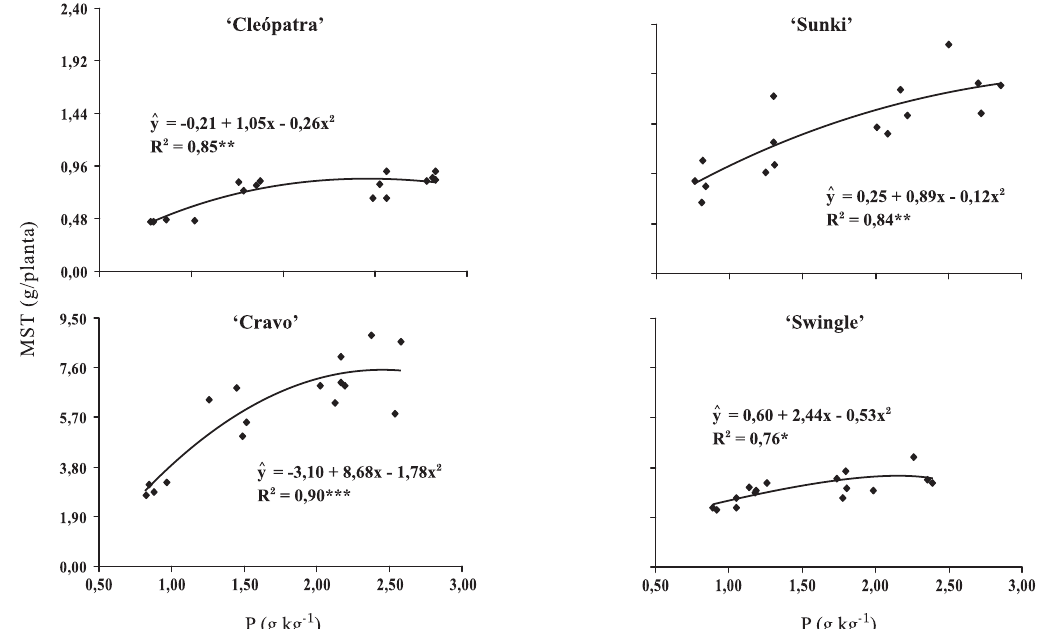
figura 3. massa seca total (mst) de quatro porta-enxertos cítricos cultivados em solução nutritiva, em função do teor de P nas folhas. *p < 0,05; ** p < 0,01; ***p < 0,001. (n=16). Quadro 1. Eficiência de absorção de fósforo (EaP), eficiência de utilização de fósforo (EUP) na parte aérea e nas raízes e atividade da fosfatase ácida nas folhas (afaf) de quatro porta-enxertos